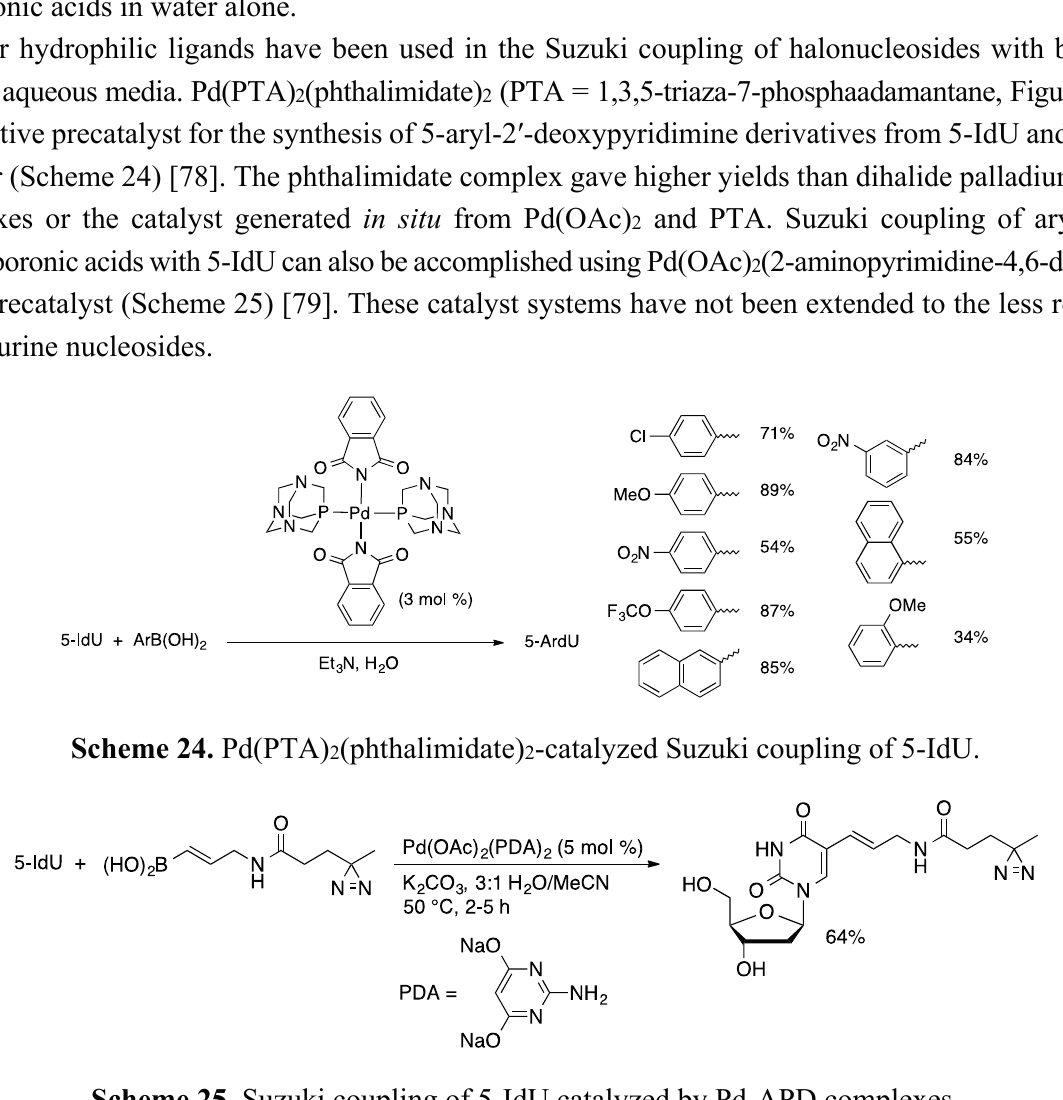
Scheme 25. Suzuki coupling of 5-IdU catalyzed by Pd-APD